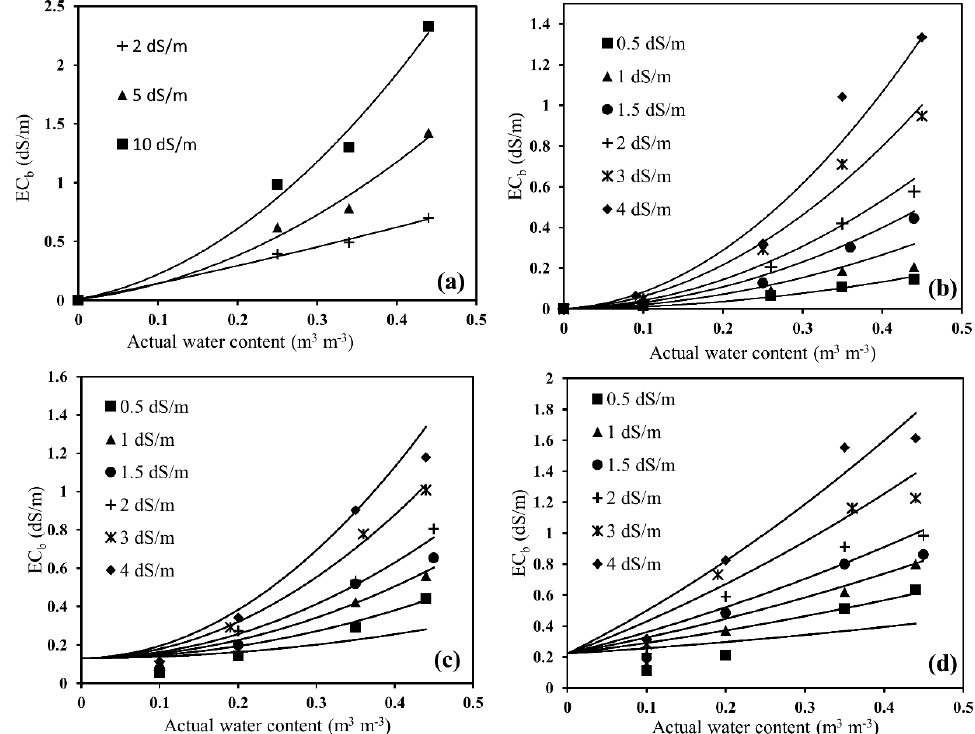
Figure 5. Calibration of sensor probe for measuring bulk electrical conductivity (EC b ) as a function of water content and salinity in ( a ) glass beads, ( b ) Oso Flaco sand, ( c ) Columbia loam, and ( d ) Yolo clay loam (in Table 5, c 1 , c 2 and c 3 are optimized parameters for the Rhoades equation [32]). Note that for both glass beads and sand, EC s can be assumed to be zero. Table 5. Optimized parameters for Rhoades model for all soils.